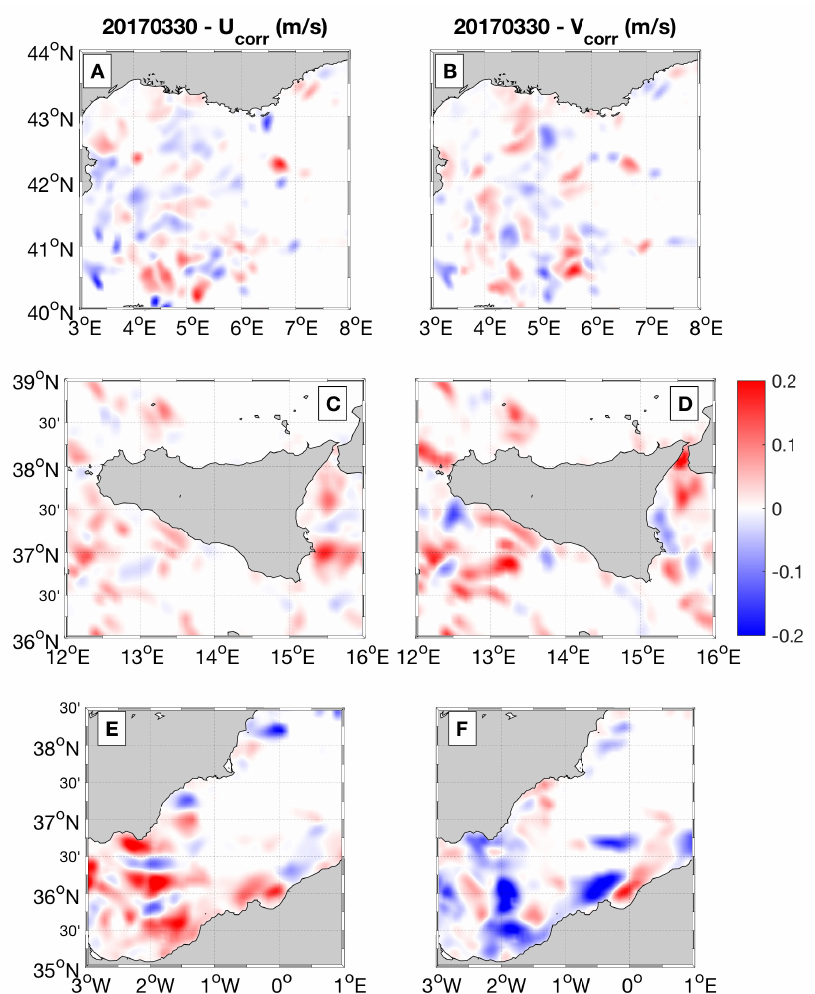
Figure 5. Correction factors for the zonal SACs in: ( A ) the Northwestern Mediterranean; ( C ) the Sicily Channel; ( E ) the Western Mediterranean; ( B , D , F ) the same as ( A , C , E ) for the meridional SACs.